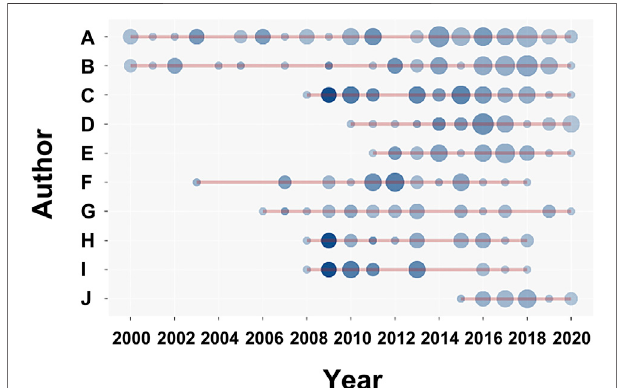
FIGURE 6 | The top ten active researchers in the fi eld of the kynurenine pathway (KP) in mood disorders and their publications over time. The larger the circle, the more articles published. The deeper the color, the more citations.